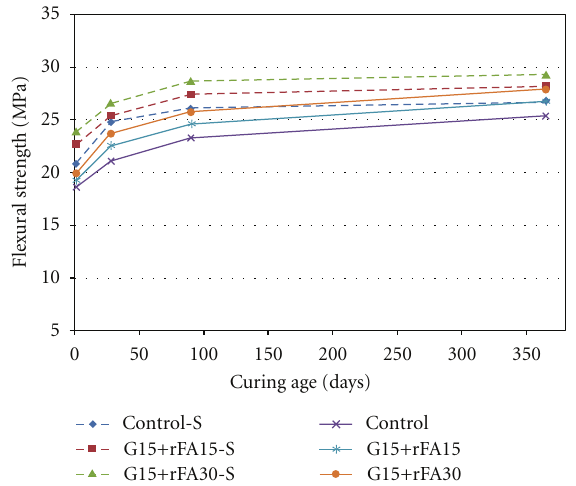
Figure 7: E ff ect of both GP and r-FA on flexural strength of UHPFRC with and without steam curing.